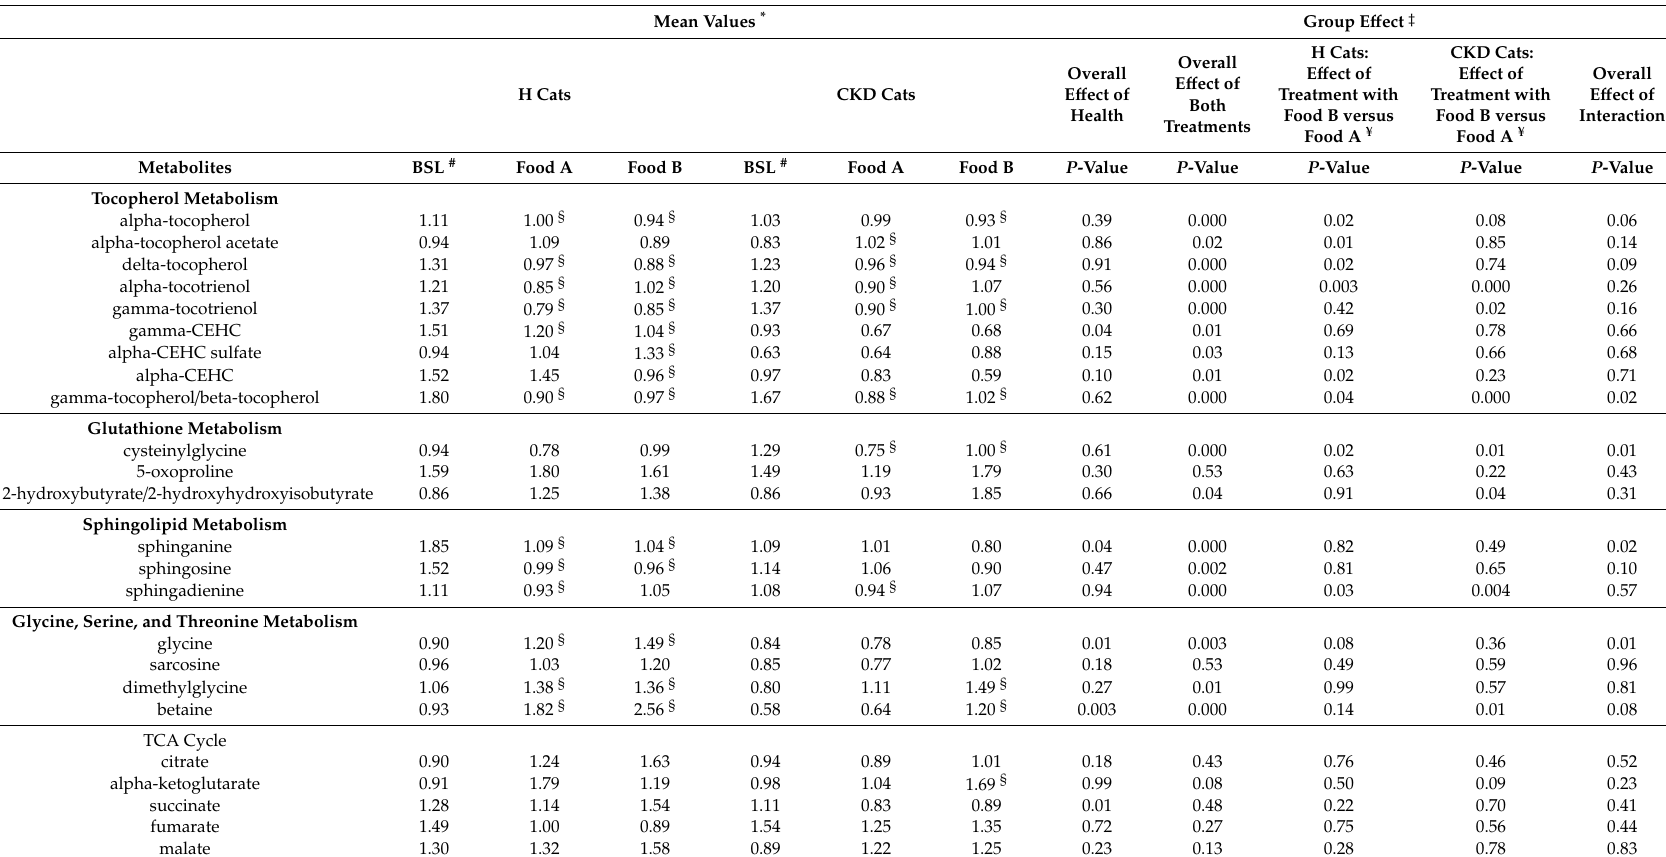
Table 1. Relative fecal metabolite concentrations for antioxidants, markers of oxidation and inflammation, methylated metabolite, TCA cycle, and urea cycle intermediates in healthy cats (H cats) and chronic kidney disease (CKD) cats at baseline (after feeding pretrial food 1 for 14 days) and after feeding food A 2 (containing scFOS) or food B 3 (containing apple pomace) as fiber sources for 4 weeks